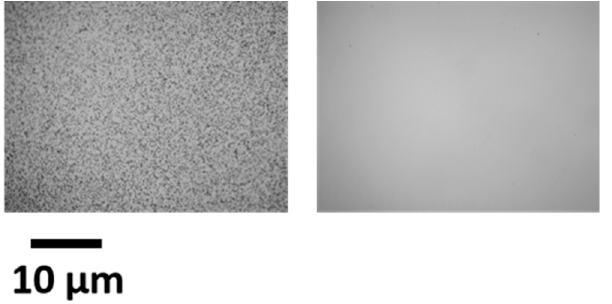
Figure 1. Optical microscopy images for samples grown at 850 ◦ C ( left ) without Cp 2 Mg, and ( right ) with 48 nmol/min of Cp 2 Mg flow.